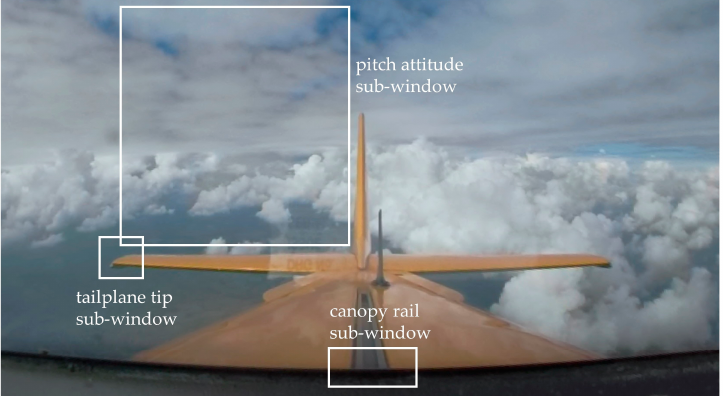
Figure 4. Tailplane view in-flight from GoPro camera system. Sub-window images indicate tailplane tip sub-window (201 pixels × 221 pixels), reference canopy rail (251 pixels × 101 pixels) and pitch attitude sub-window (910 pixels × 640 pixels). Table 1. Summary of flight test conditions for the tailplane stall test.